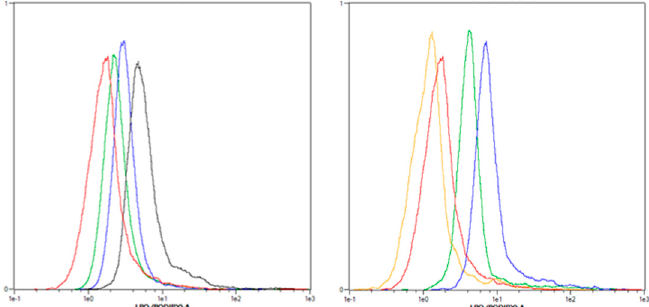
Figure A2. Representative flow cytometric analysis of LPO in SISO cells. Cells were treated with solvent (red and yellow), t -BHP (black), and the IC 50 (green) or IC 90 (blue) of mTHPC. Afterwards, cells were kept in the dark (left) or illuminated with 1.8 J / cm 2 (right) and stained with BODIPY 665 / 676 24 h after illumination. For each sample, 10,000 events were counted and gated for the single cell population (not shown). BODIPY 665 / 676 fluorescence was detected with the APC channel ( λ Ex / Em = 635 / 655–730 nm) of a MACS Quant flow cytometer. Data were analyzed with the MACS Quantify Software.